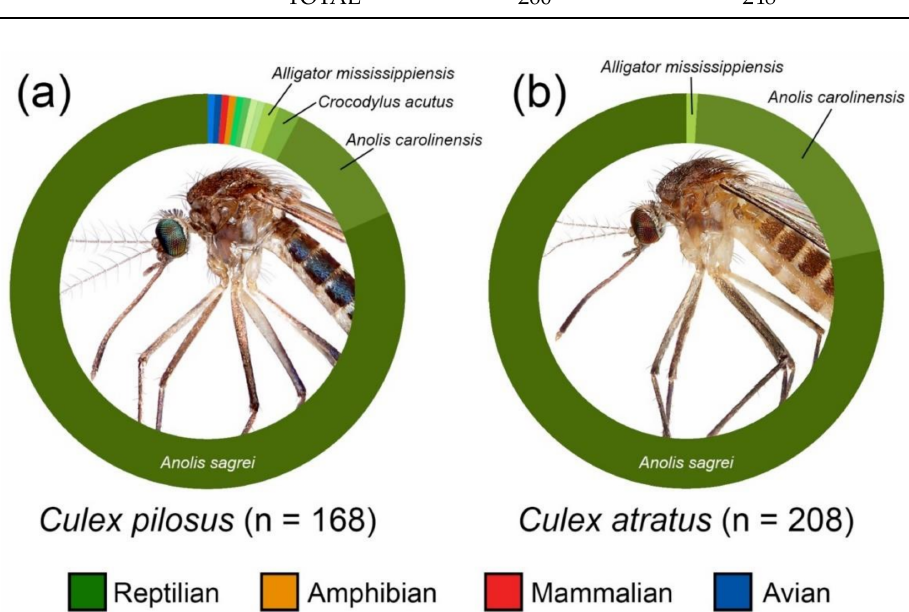
Figure 2. Composition of hosts identified from samples of ( a ) Culex pilosus and ( b ) Culex atratus blood meals collected in Everglades National Park, Florida USA by host class. Colors (green, orange, red, blue) indicate host class. Shades of each color indicate host species within each respective class. Host species represented by > 1 blood meal are